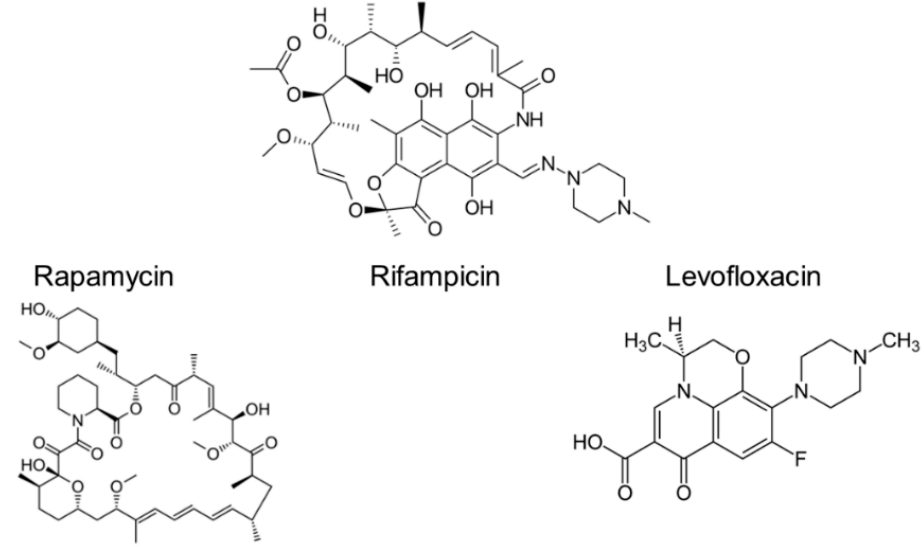
Figure 1. Structures of rapamycin, rifampicin and levofloxacin.